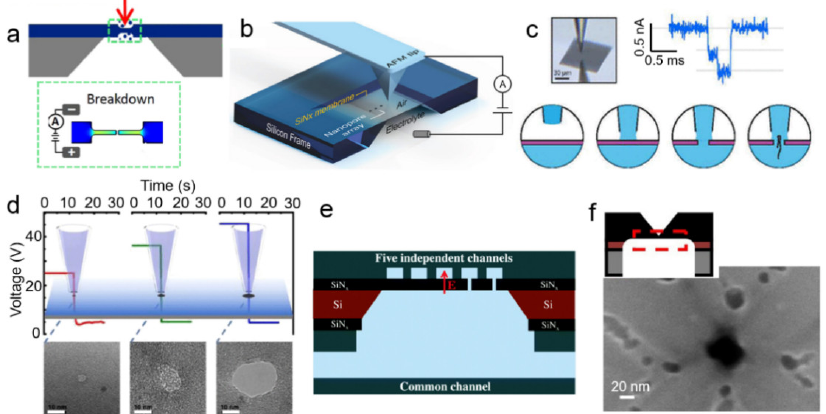
Figure 5. Tip-induced breakdown. ( a ) Schematic of a thinned area in a SiN x membrane introduced via helium-ion beam. The inset in the green box shows the localized breakdown at the pre-thinned region. Adapted with permission from Ref. [150]. Copyright 2017 IOP Publishing. ( b ) 3D schematic of an experimental setup for AFM tip-controlled local breakdown (TCLB). Nanopore arrays are formed by controlling the position and the voltage of the AFM tip. Reprinted with permission from Ref. [153]. Copyright 2019 John Wiley & Sons, Inc. ( c ) Schematic of experimental setup of local breakdown introduced by micro-liquid conduction using a micropipette. Adapted with permission from Ref. [154]. Copyright 2017 American Chemical Society. ( d ) Transient high electric-field breakdown by the meniscus contact of a micropipette with the SiNx membrane [151,152]. Figures reprinted with permission from Ref. [151]. Scale bars are 10 nm. ( e ) A five-channel microfluidic system allows the formation of nanopores at precise locations on the membrane by controlling the electric field and electrolyte [155,156]. Reprinted with permission from Ref. [155]. ( f ) A schematic illustration of the tip of an inverted pyramid along with an SEM image showing a nanopore formed in the tip region. Adapted with permission from Ref. [196]. Copyright 2021